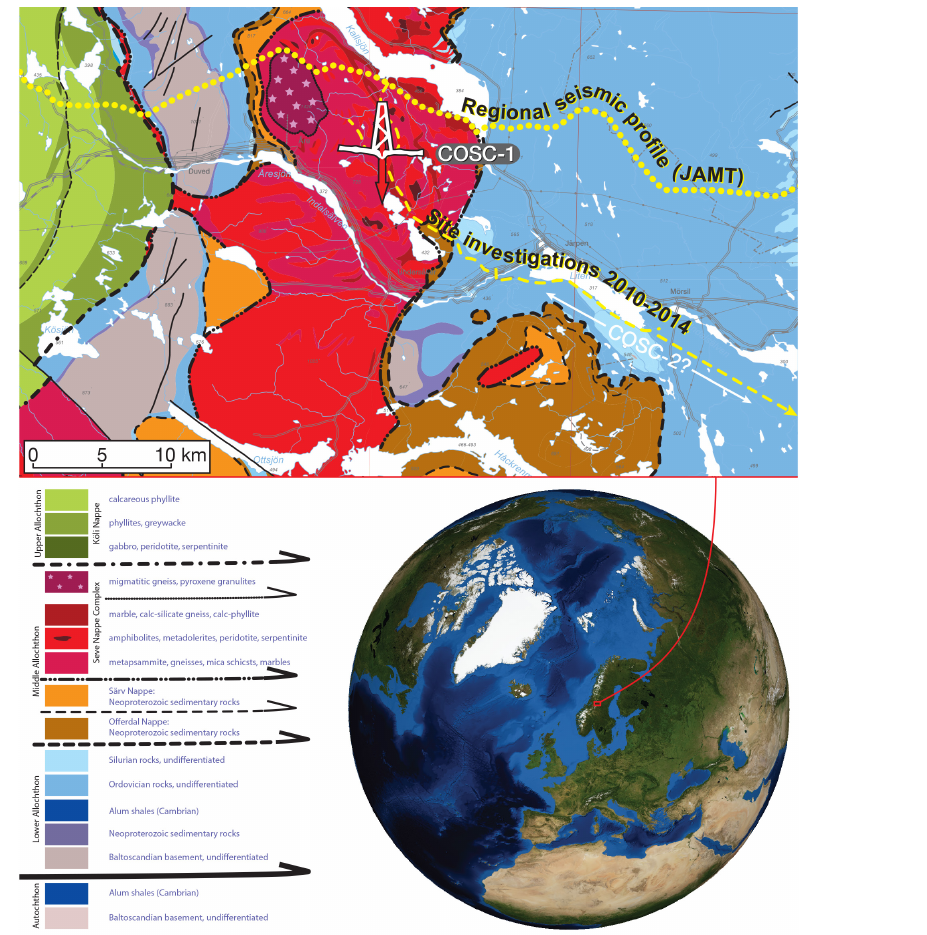
Figure 4. Tectonostratigraphic map of the Åre-Järpen area (based on the 1:200000 scale geological map by the Geological Survey of Sweden). The map shows the COSC-1 drill site and relevant geophysical surveys in relationship to the tectonic units of the Scandinavian